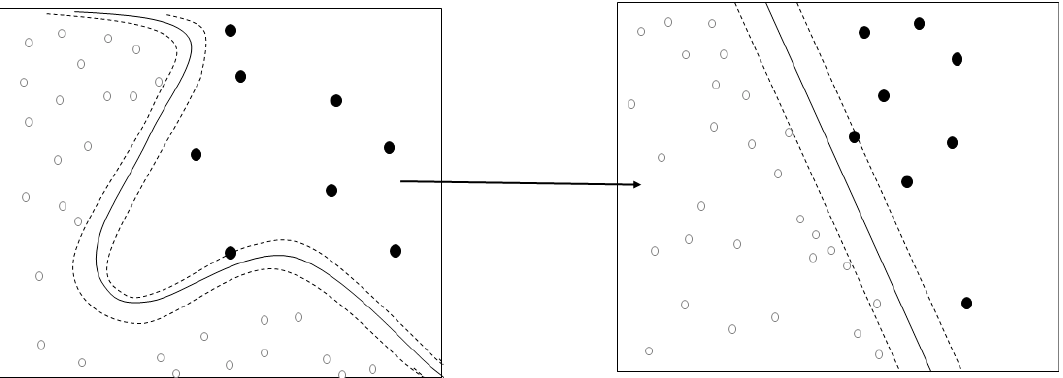
Figure 1. Concepts of kernel algorithm.